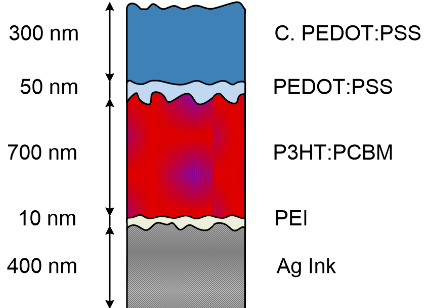
Figure 3. Cross-sectional view of the OPD. An inkjet printed Ag line modified with spray-coated PEI is used as reflective bottom-electrode, while a 700 nm thick blend of P3HT and PCBM is used as photoactive layer. The top semi-transparent electrode is obtained via a mixture of the conductive polymer PEDOT:PSS.